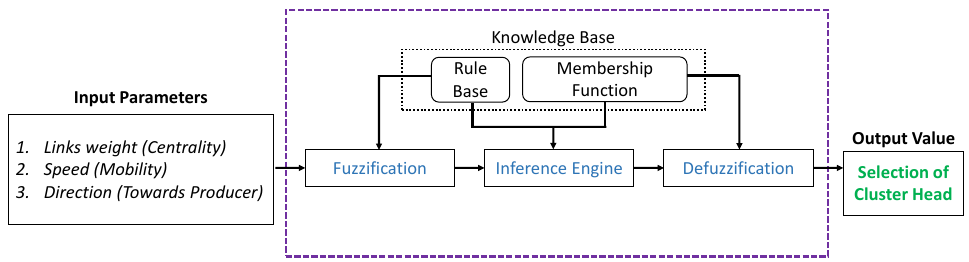
Figure 4. The fuzzy logic method used to select the